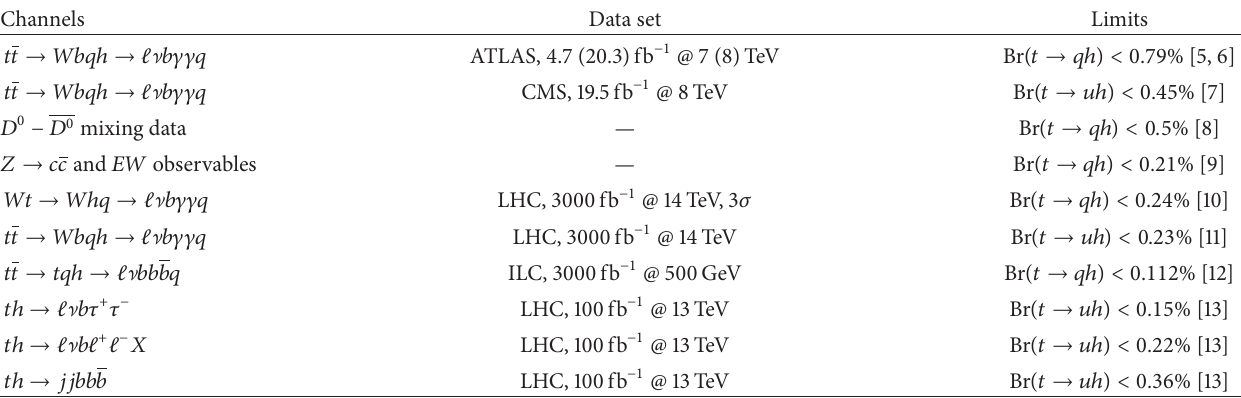
Table 1: The results from different experimental and phenomenological